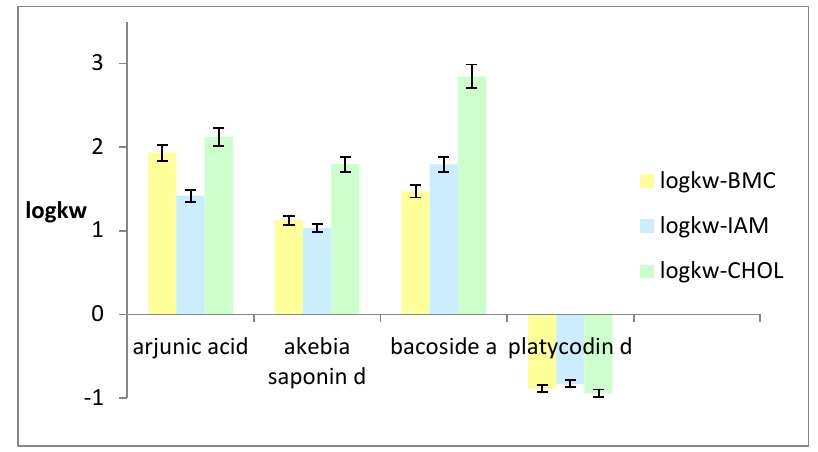
Figure 1. Logkw-BMC, logkw-IAM, and logkw-CHOL values obtained from the tested systems.